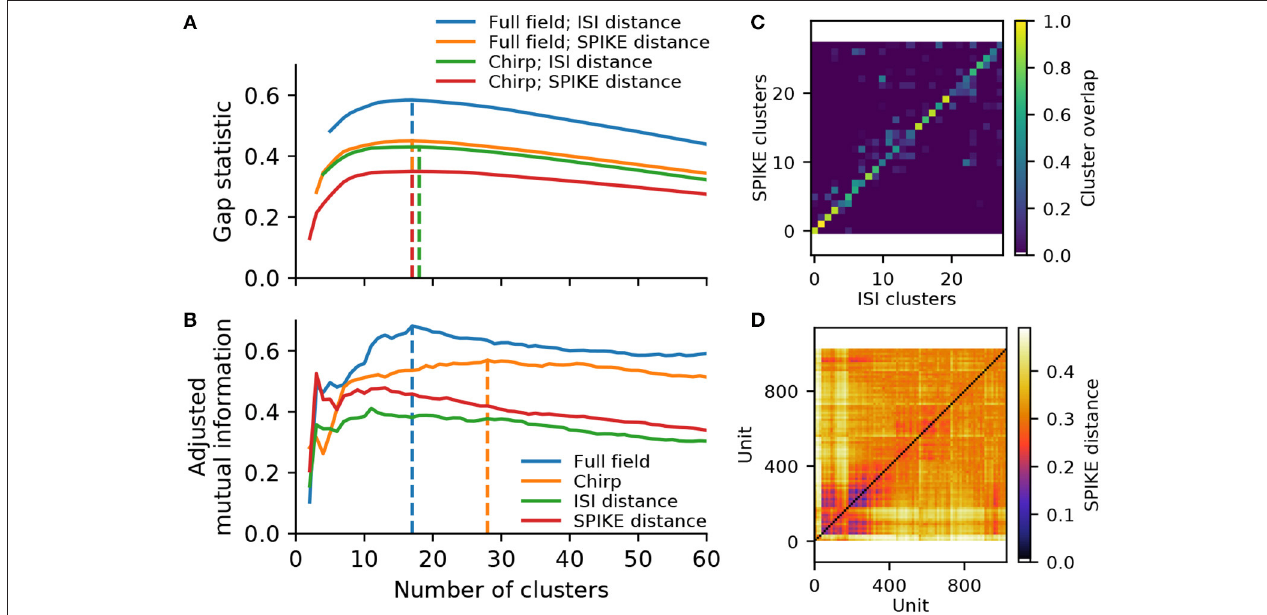
FIGURE 5 | Cluster metrics for a recording from 1,026 retinal ganglion cells. (A) The Gap statistic for the two spike distance metrics, computed for the full field and chirp stimulus, as a function of the number of flat clusters. Vertical lines indicate the peak of each curve. (B) Paired comparison of different clustering outcomes, quantified using adjusted mutual information. Two pairings were performed: between the ISI and SPIKE distance metrics for full field (blue) and chirp (orange), and between the two stimuli (full field and chirp) for either ISI (green) or SPIKE (red) distance. Vertical lines indicate the peak values for the comparison between spike distances. (C) Overlap between clusters obtained with the ISI and SPIKE metric, for 31 flat clusters. (D) The SPIKE distance matrix for all units, ordered by linkage.